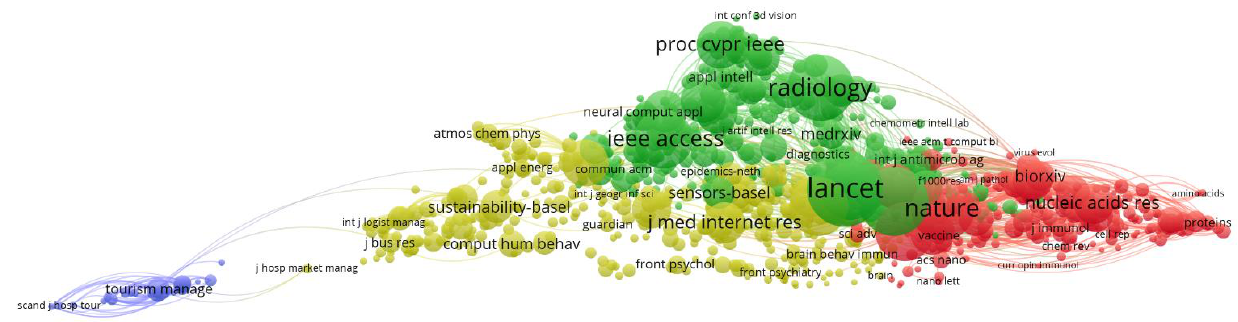
Figure 11. Co-citation mapping by sources (source